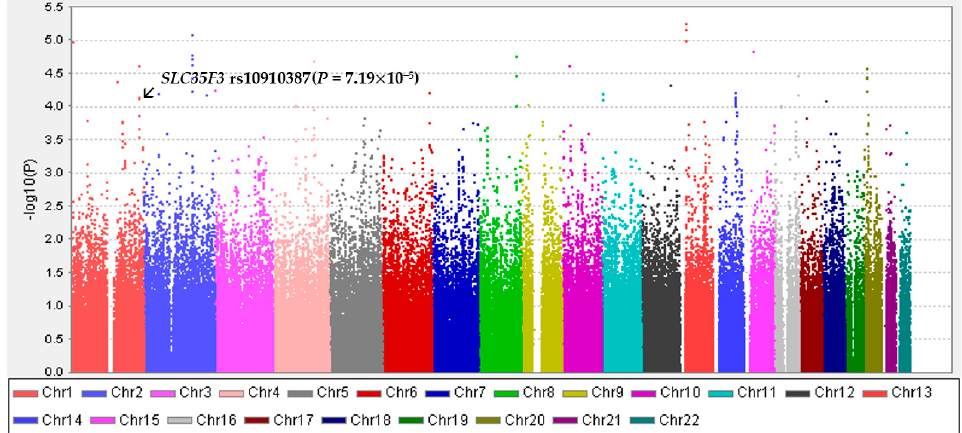
Figure 2. Manhattan plots for genome-wide association study (GWAS) of metabolic syndrome.